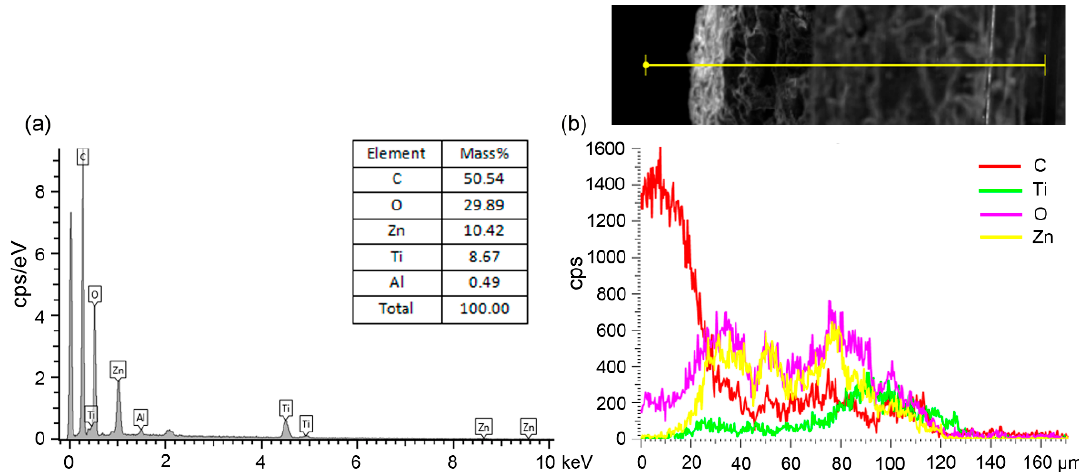
Figure 3. ( a ) EDS spectra of the ZnO/TiO 2 -B and the content of each element (inset); and ( b ) SEM in the line scanning mode and the element distribution across the ZnO-TiO 2 coating.